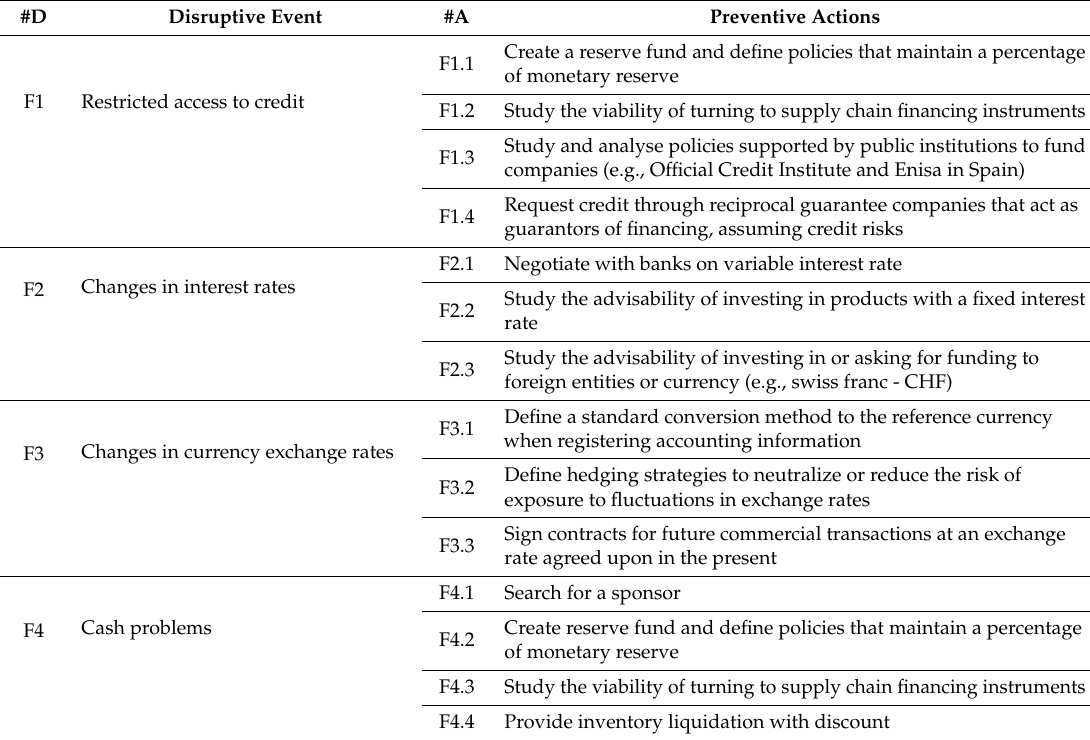
Table 8. Summary of disruptive events related to financial aspects and preventive actions.